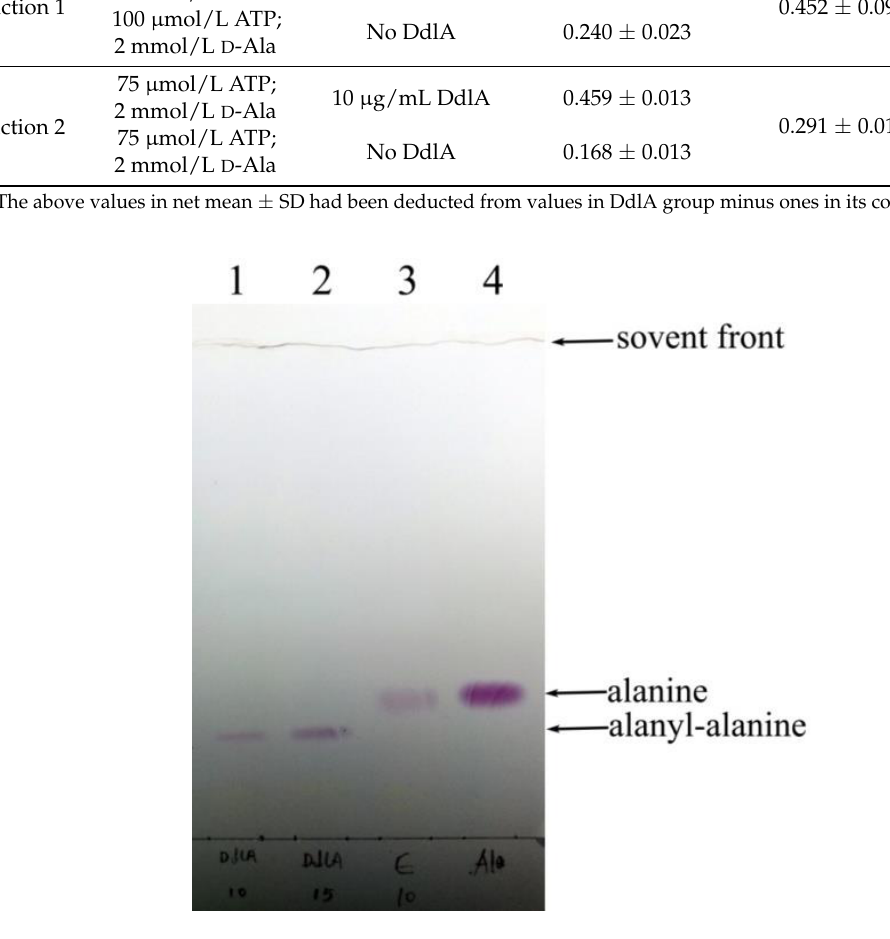
Figure 3. The identification of D -alanyl- D -alanine ligase activity of Tb -DdlA by HP-TLC. Phenol:water of 4:1 was used as the developing reagent. The color spots were visualized by